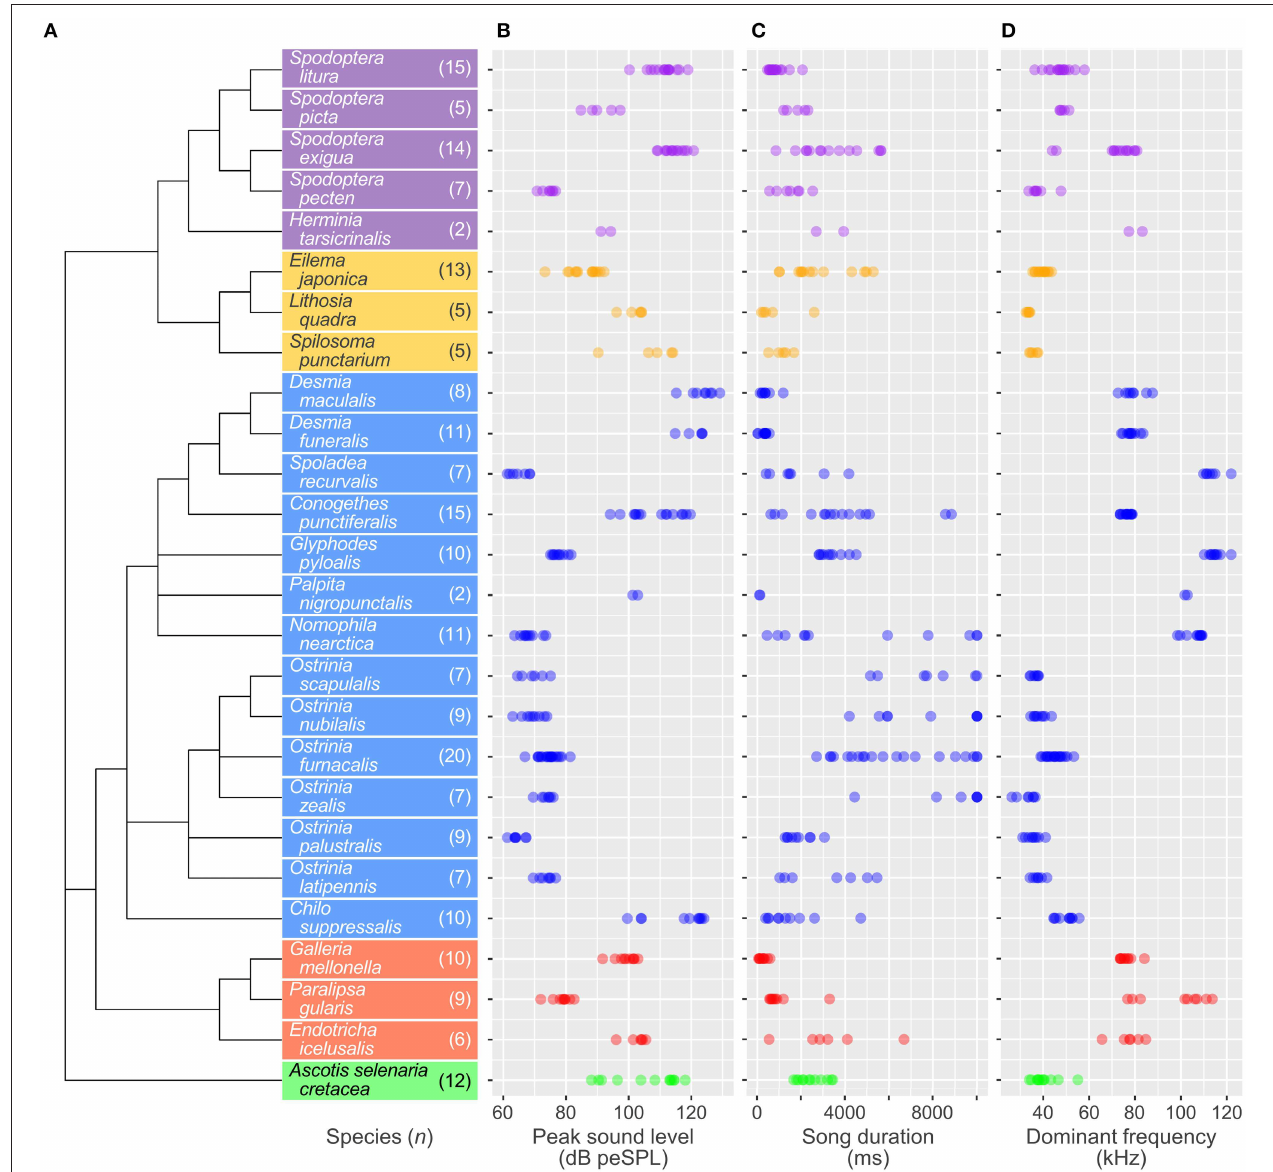
FIGURE 2 | Phylogenetic relationship of the 26 moth species and acoustic characteristics of male ultrasonic courtship songs in each species. (A) The phylogenetic tree was constructed by the maximum likelihood method. Colors indicate taxonomic families: purple, Noctuidae (Noctuoidea); orange, Erebidae (Noctuoidea); blue, Crambidae (Pyraloidea); red, Pyralidae (Pyraloidea); green, Geometridae (Geometroidea). The sample sizes used for acoustic analysis are shown in parentheses after the species names. Distribution of peak sound level (B) , song duration (C) , and dominant frequency (D) of male songs. Each circle denotes a value extracted from an individual singing